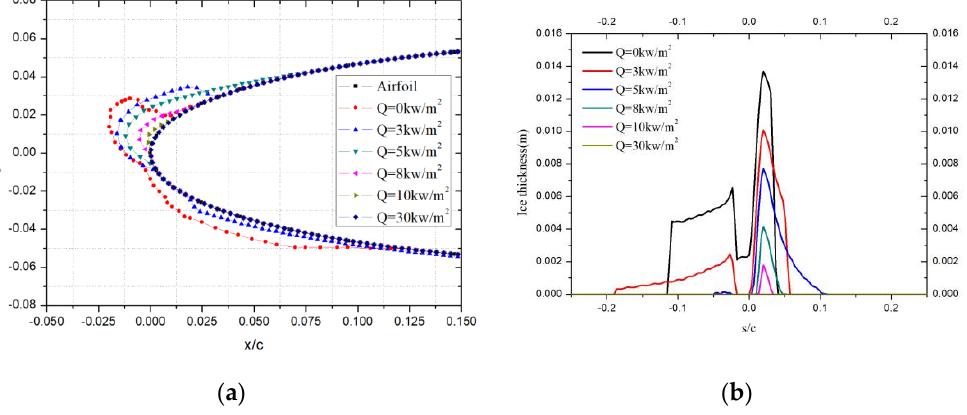
Figure 4. Icing characteristics with protection range of s / c = ±0.2: ( a ) Ice shapes; ( b )Ice thickness.